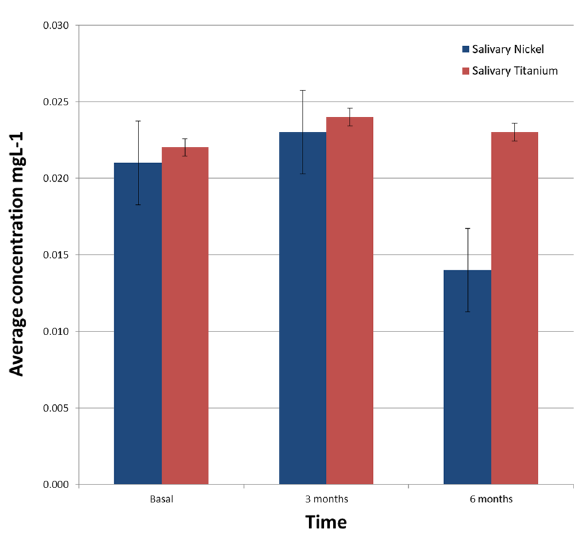
Figure 1. Concentration of Ni and Ti in saliva in each stage of intervention. The error bar represents the ± standard deviation